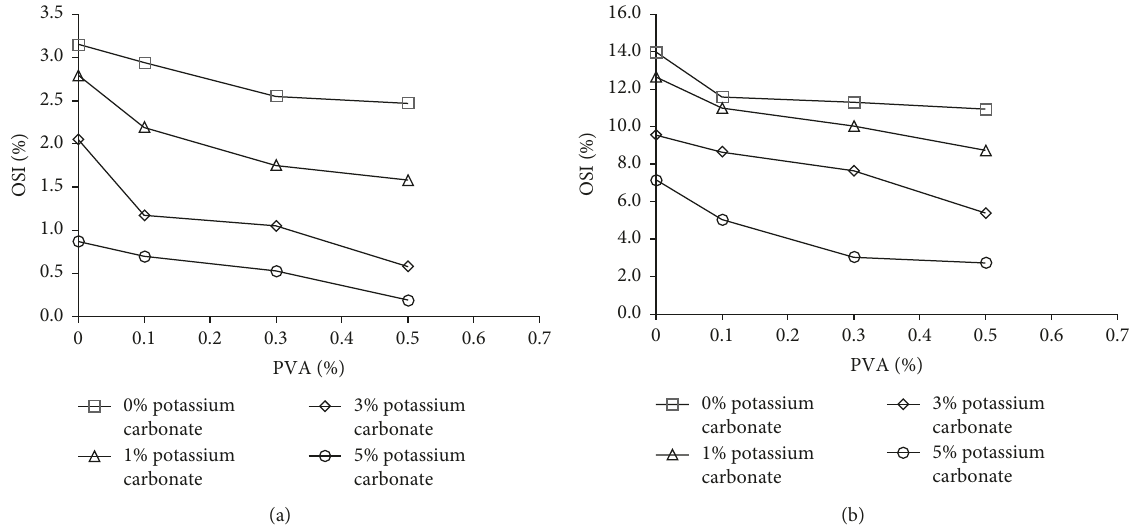
Figure 3: Oedometric swell test results (a) with a 50kPa vertical load; (b) without vertical load.